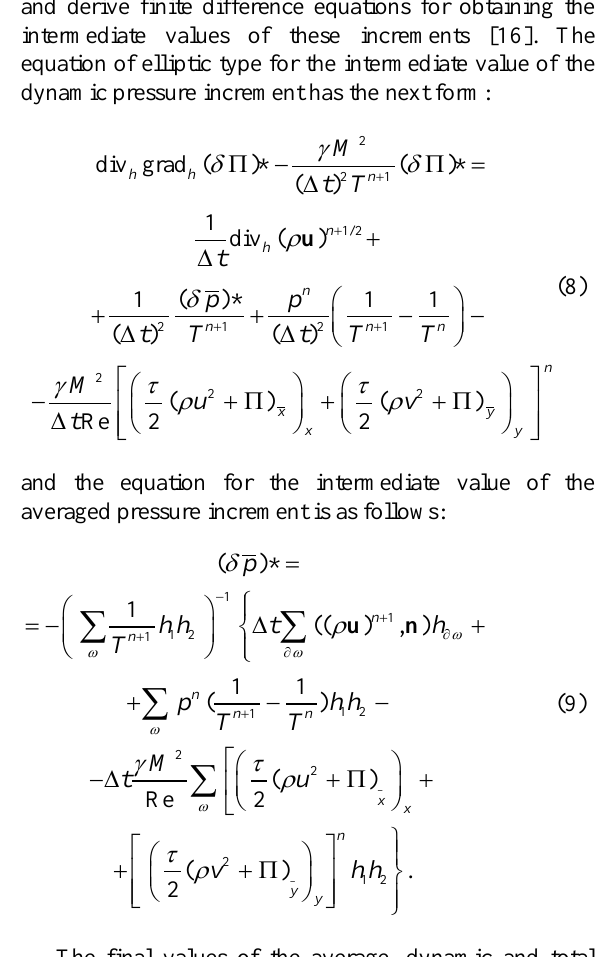
Fig. 6 . Statement of the problem of flow around the body of complex